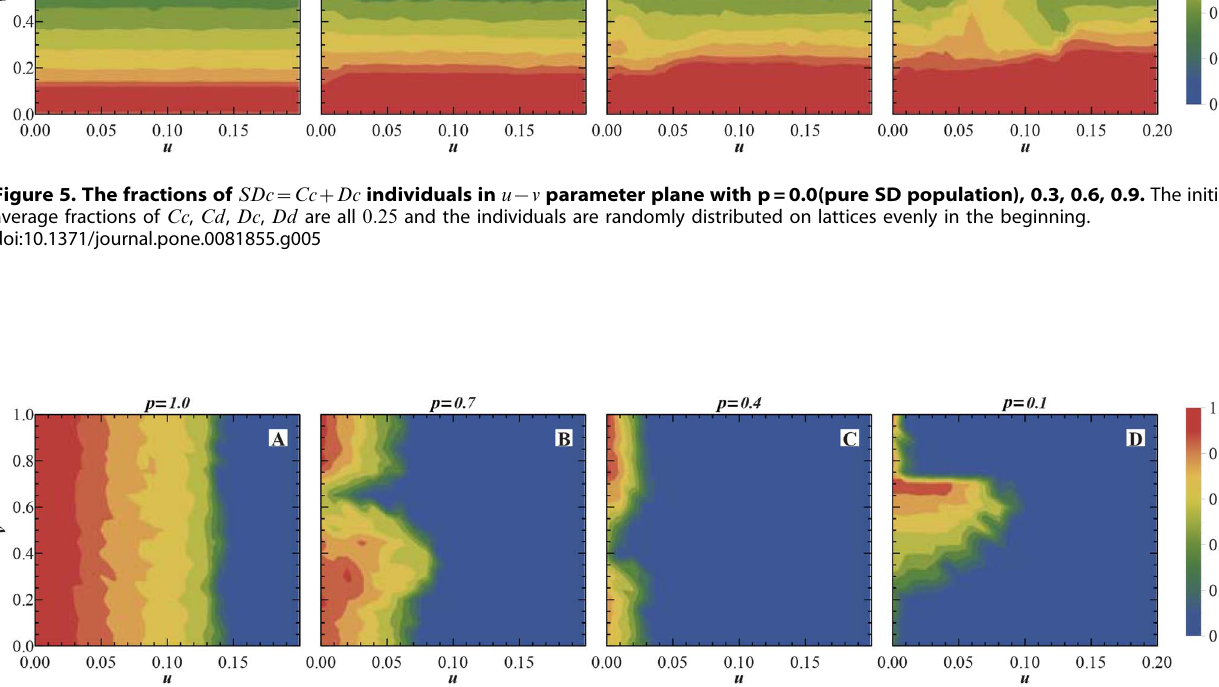
Figure 6. The fractions of PDC ~ Cc z Cd individuals in u { v parameter plane with p ~ 1 : 0 (pure PD population), 0 : 7 , 0 : 4 , 0 : 1 . The initial fractions of Cc , Cd , Dc , Dd are all 0 : 25 and the individuals are randomly distributed on lattices evenly in the